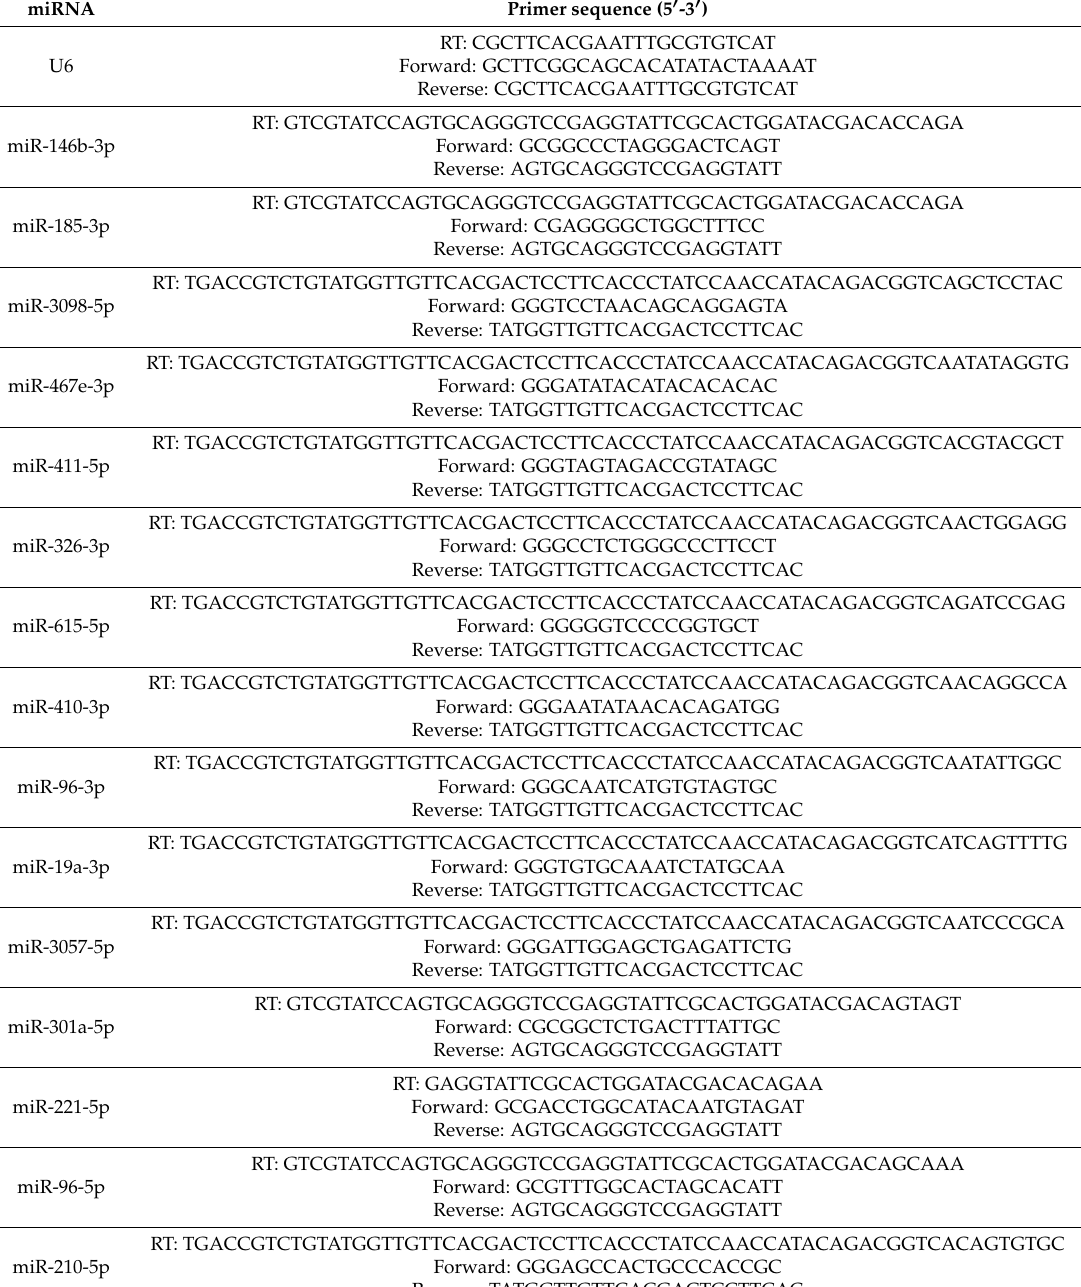
Table 3. Primer sequences of miRNA used in this study for quantitative real-time